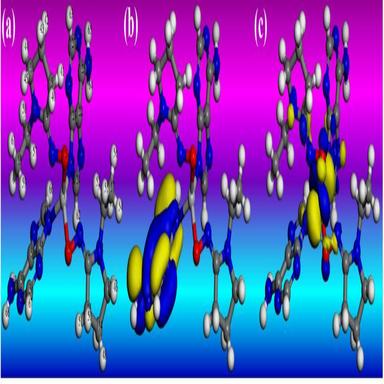
(a) Optimized molecular structure and frontiers orbitals distribution (b) HOMO and (b) LUMO of the inhibitor.